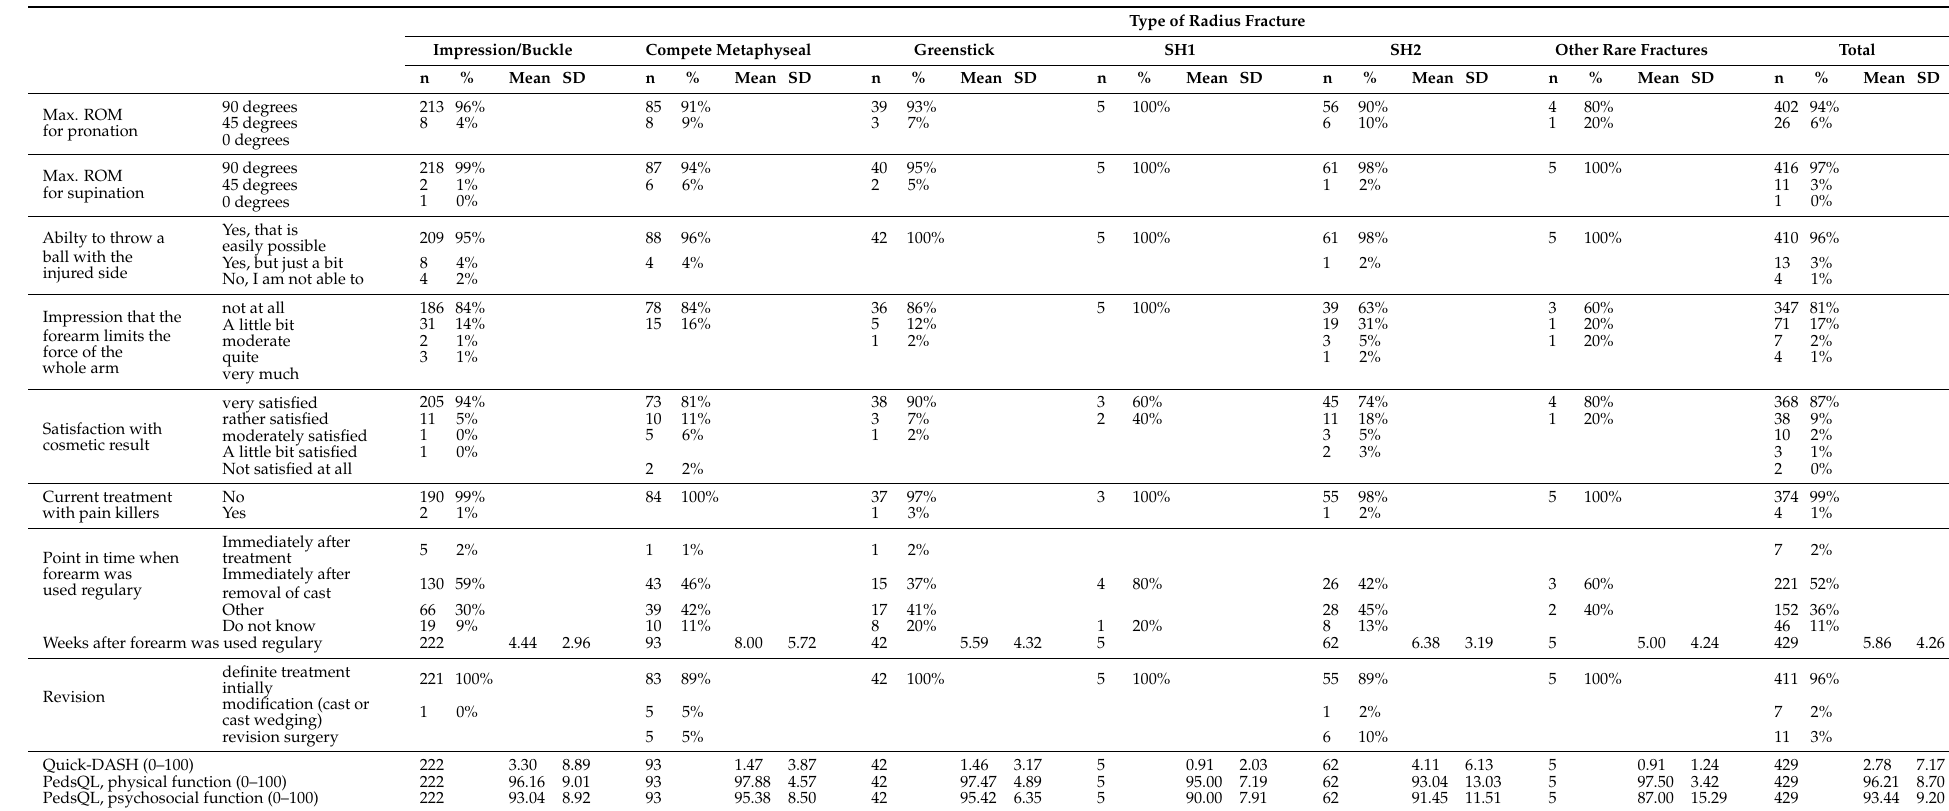
Table 2. Results by type of radius